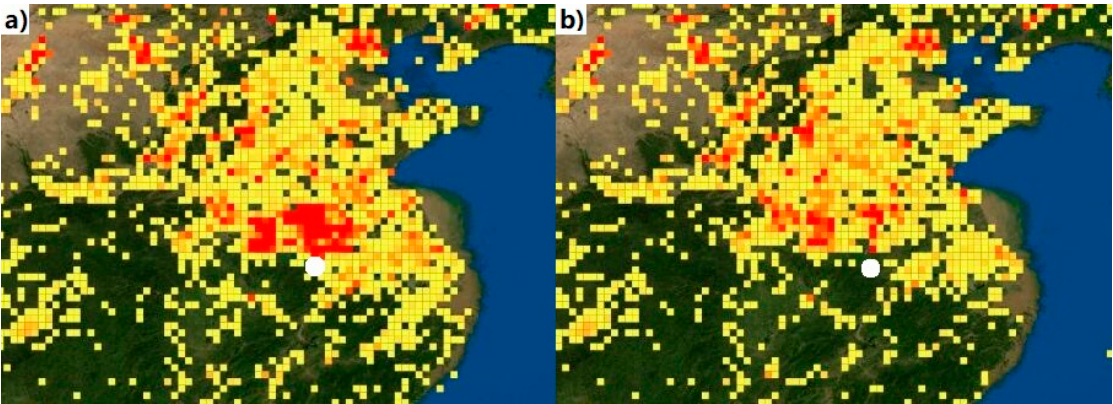
* Note: mean values for air temperature (T), relative humidity (RH), wind speed (WS), accumulated value of precipitation (Pre).